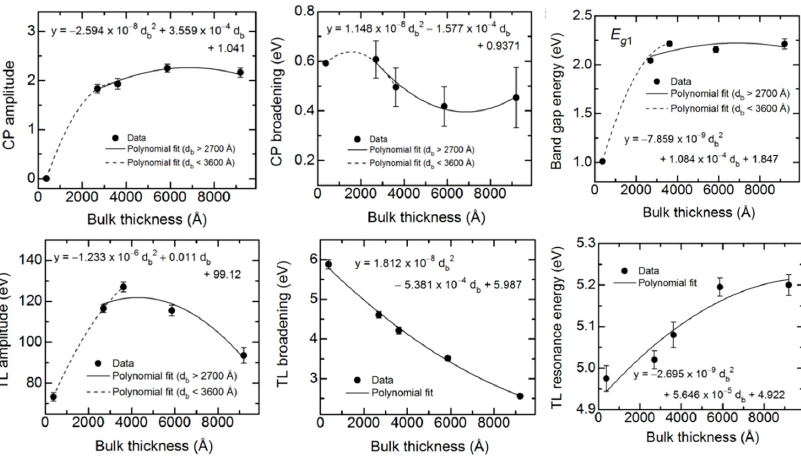
Figure 10. Best fit critical point (CP) and Tauc-Lorentz (TL) oscillator parameters (points) plotted versus bulk layer thickness for (In 1 − x Ga x ) 2 Se 3 with x = 0.30, along with best fit polynomial relationships (lines). For Г 2 and E 02 , a single polynomial spans the full range of bulk layer thickness, whereas for all other parameters, two polynomial segments are needed. For the latter set of parameters, the equation provides the higher thickness polynomial segment. Over the low thickness range (broken